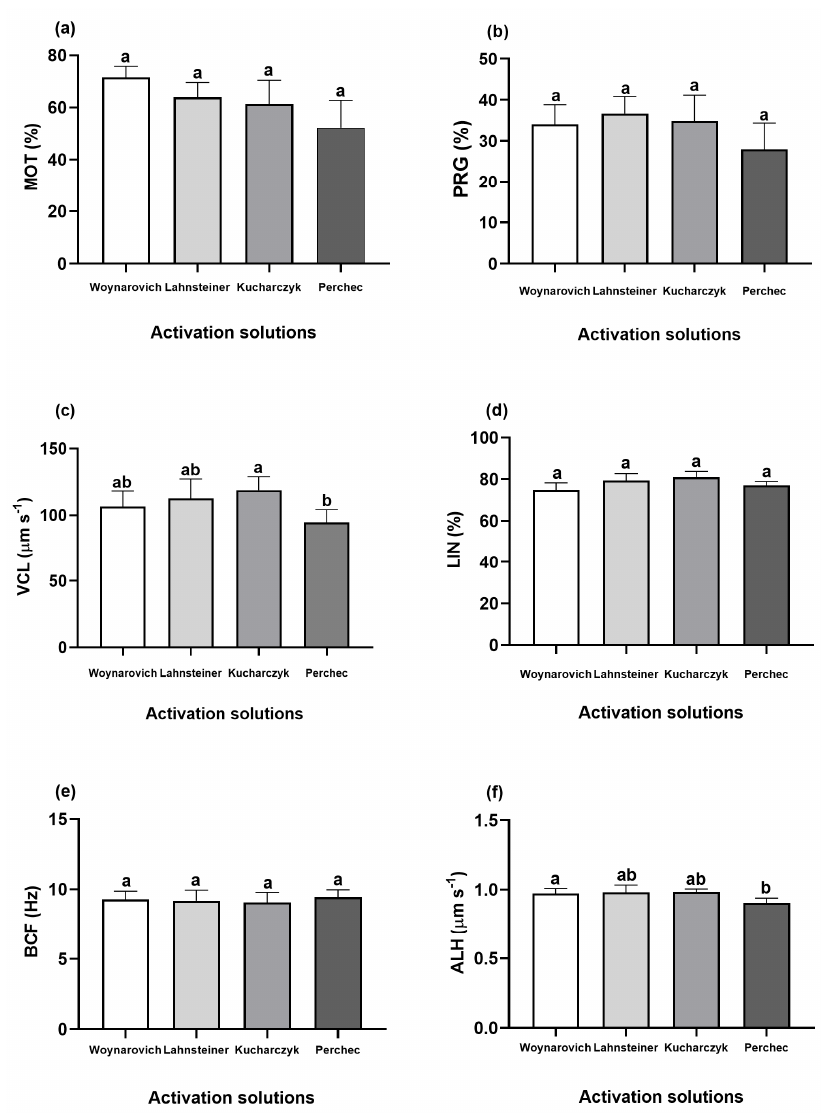
Figure 1. Percentages of motile sperm ( a ), progressively motile sperm ( b ), curvilinear velocity ( c ), movement linearity ( d ), beat cross frequency ( e ), and amplitude of lateral head displacement ( f ) in solutions supplemented with 0.5% BSA with different ion compositions, pH values, and osmolalties used to activate ide ( Leuciscus idus ) sperm (n = 5). Results presented as mean ± SEM ( p < 0.05). Boxes labeled with different letters indicate statistically significant differences ( p < 0.05).